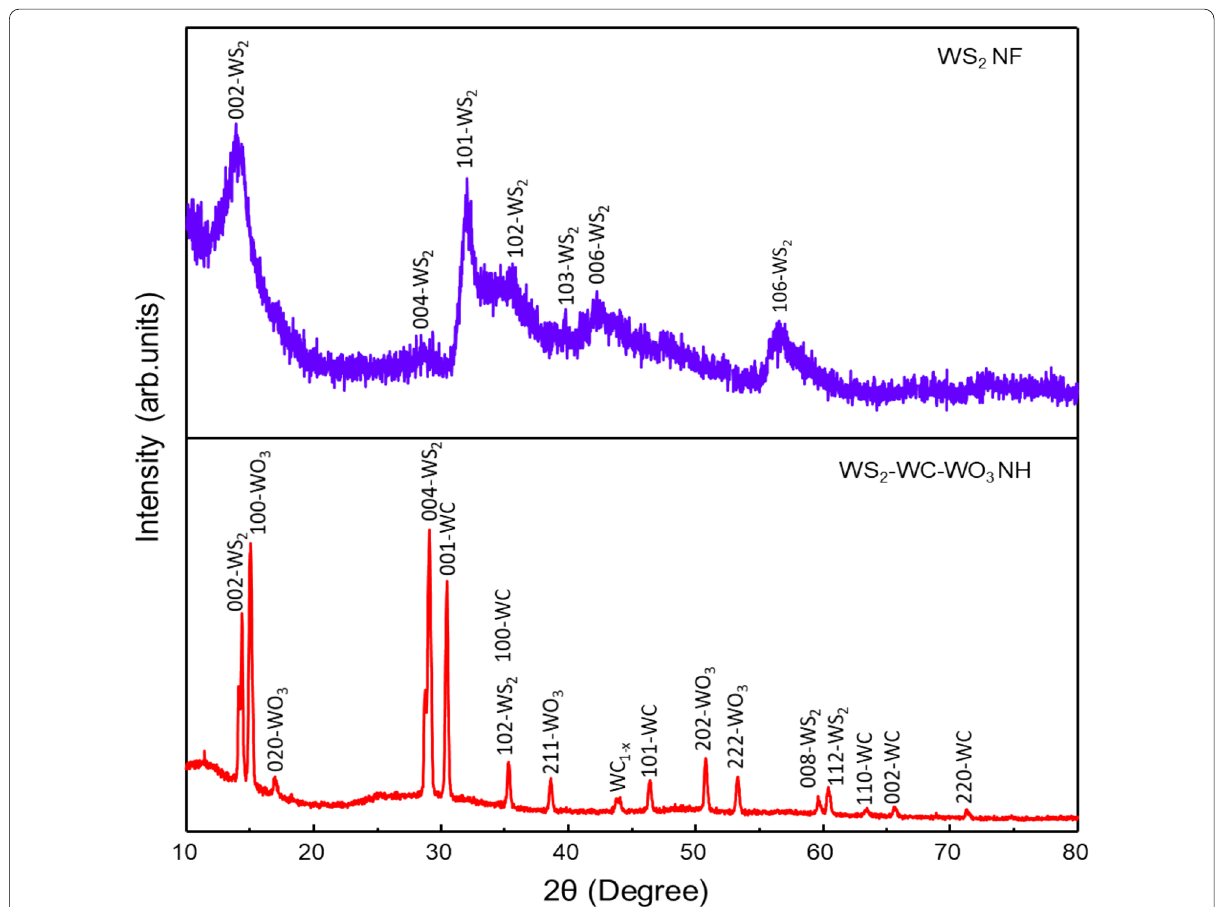
Fig. 1 XRD patterns of the WS 2 NFs and WS 2 /WC/WO 3 NH